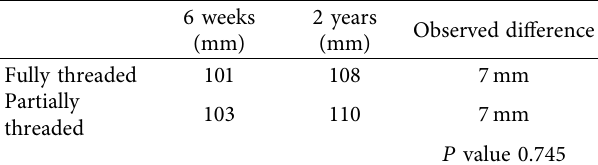
Table 2: Neck length. Figure 3: Articular-trochanteric distance. A horizontal line is